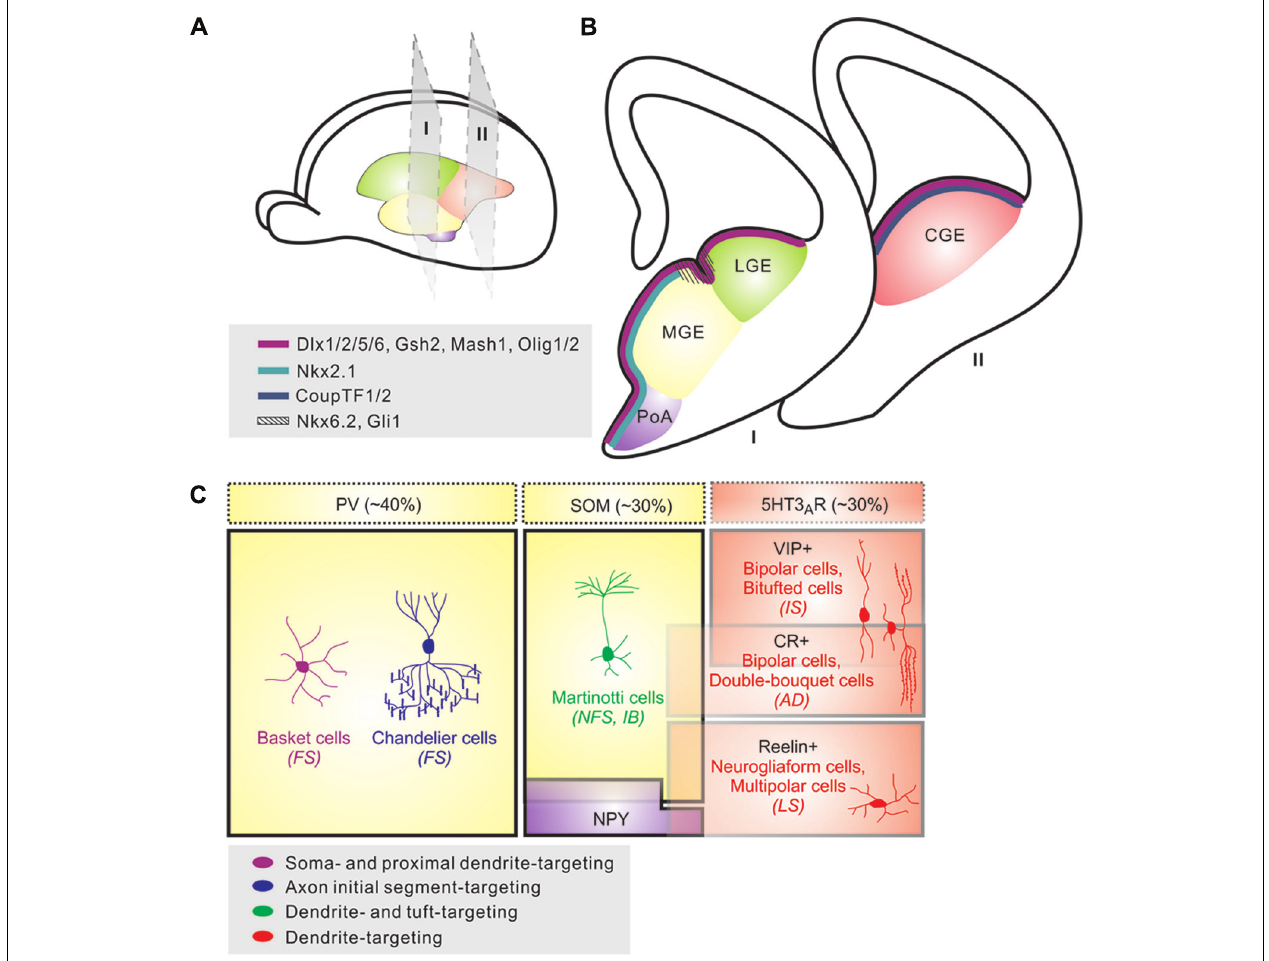
About 40% of neocortical interneurons exhibit fast-spiking (FS) electrophysiological profiles, and are comprised of basket and chandelier cells; these cells largely express parvalbumin (PV), although some chandelier cells are PV-negative. Cells expressing somatostatin (SOM) account for ∼ 30% of the neocortical interneurons that are morphologically heterogeneous (e.g., Martinotti cells) and typically exhibit non-FS comprised of vasointestinal peptide (VIP)-expressing and/or calretinin (CR)-expressing cells with bipolar or double-bouquet morphologies and fast cortical interneurons consists of multipolar cells that contain NPY and display irregular or fast AD firing